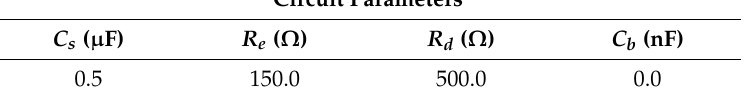
Table 9. Selected circuit parameters of the lightning impulse voltage generation circuit.